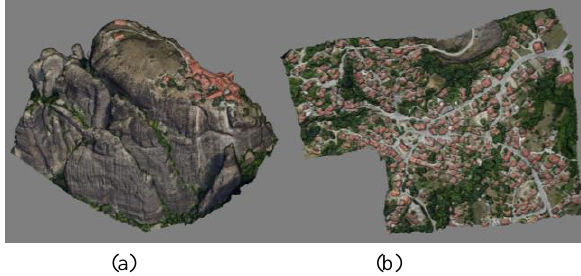
Figure 2. Input 3D models of the AR